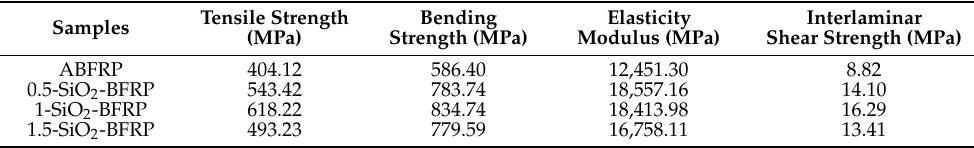
Table 4. Mechanical strength of composites before and after modification.